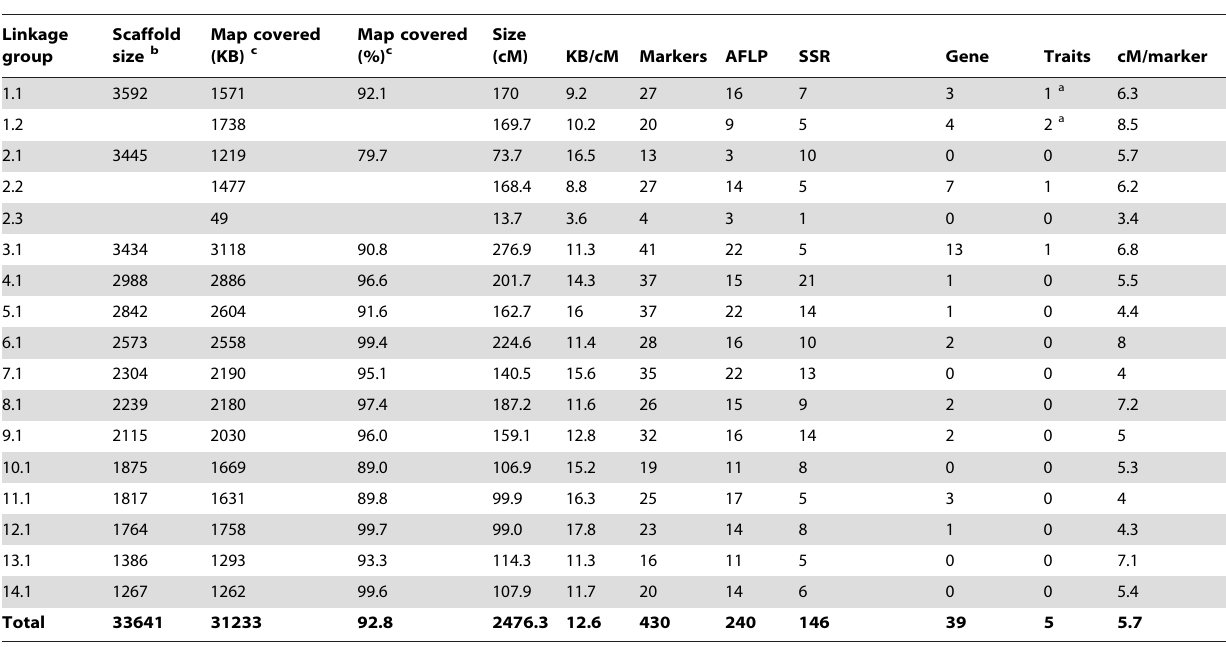
Table 2. Numeric data for each linkage group in the 2 nd generation linkage map for Heterobasidion annosum s.l.